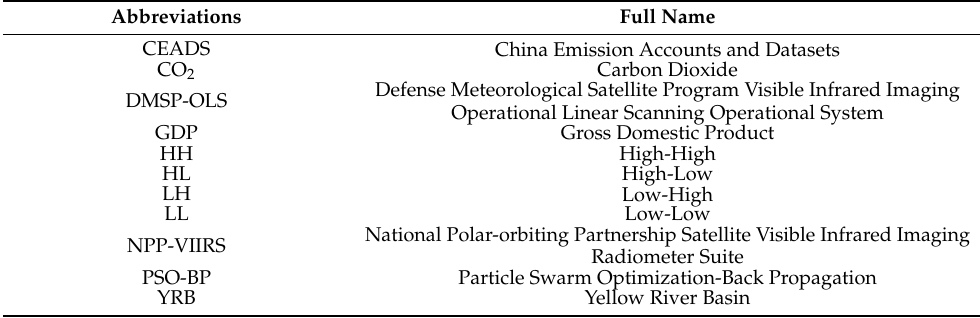
Table 5. List of